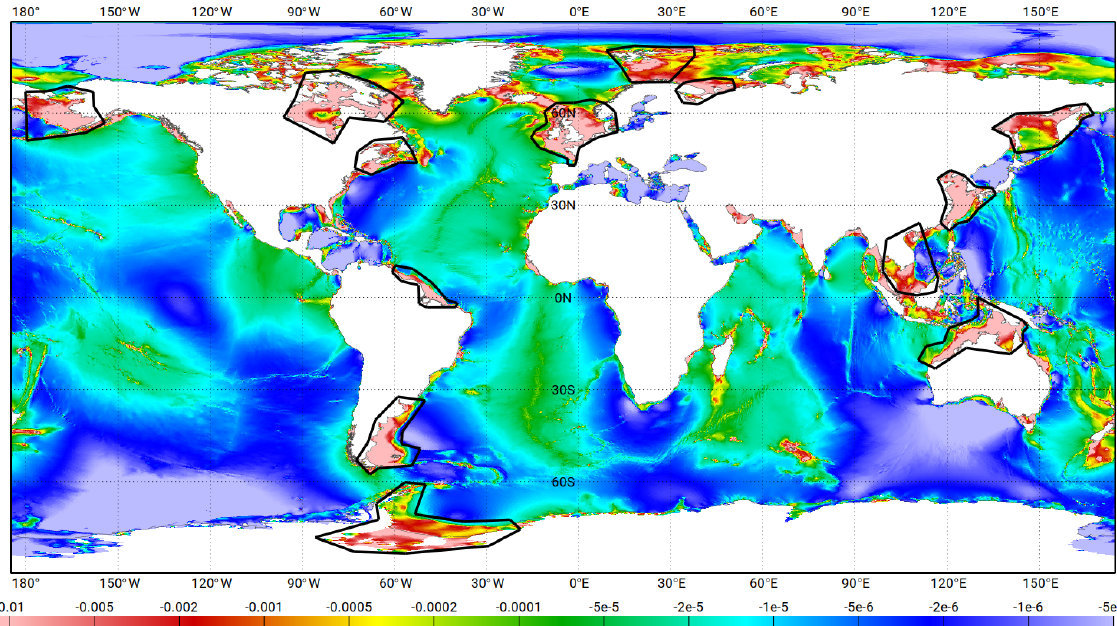
Figure 6. Energy (Wm − 2 ) dissipated by bottom friction in the FES2014 hydrodynamic model, for the M2 wave, and polygons used for the perturbations of the bottom friction